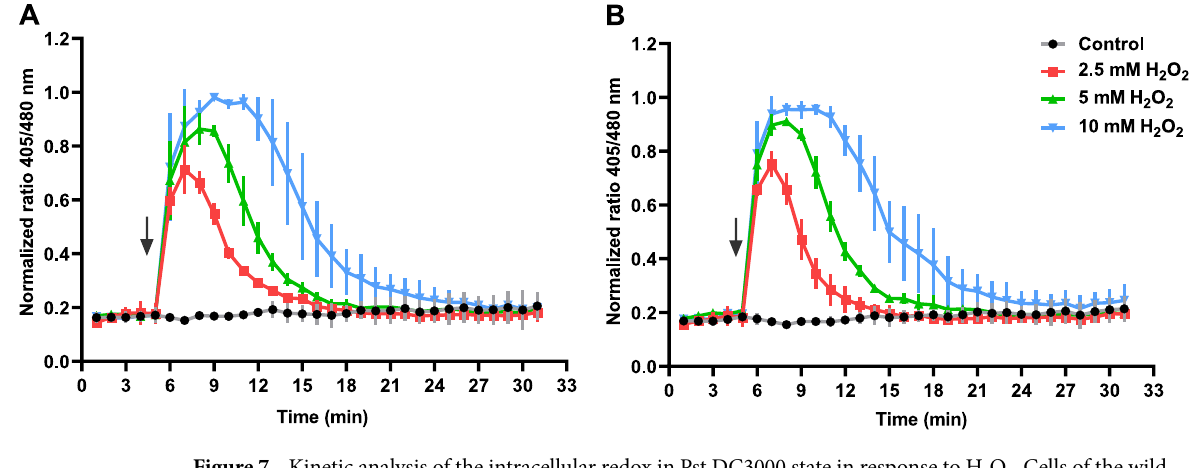
Figure 7. Kinetic analysis of the intracellular redox in Pst DC3000 state in response to H 2 O 2 . Cells of the wild type ( A ) and ∆ speE ( B ) strains expressing roGFP were exposed to different concentrations of H 2 O 2 (arrows indicate the time of addition). Data points represent the intracellular redox state as the quotient of the excitation fluorescence values at 405 and 480